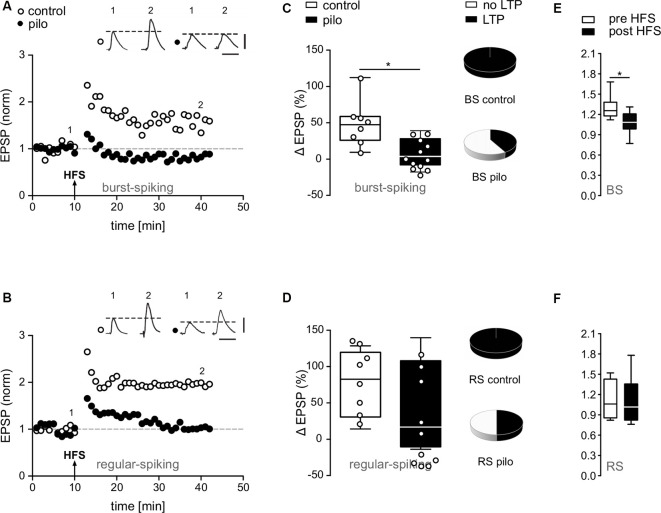
Impairment of synaptic plasticity in subicular pyramidal cells of pilocarpine-treated animals. (A,B) EPSP time courses from single cell recordings in subicular BS and RS cells before and after HFS. Note the loss of LTP in putative subicular BS and RS cells of pilocarpine-treated animals after HFS. (C,D) Summary of relative changes in synaptic strength upon HFS shown as box plots with whiskers from minimum to maximum and line at median (Control BS: 44.8 ± 1.4%, n = 8, Pilo BS: 7.6 ± 2.1%, n = 12, p = 0.004; Control RS: 75.9 ± 15.7%, n = 8, Pilo RS: 40.4 ± 19%, n = 10, p = n.s.). Pie charts depict fractions of BS and RS cells in control and pilocarpine-treated animals showing LTP. While in control animals all BS and RS cells showed a significant degree of LTP, in pilocarpine-treated animals, only five out of 10 putative RS cells and five out of 12 putative BS cells showed LTP. (E,F) The expression of LTP in control animals was accompanied by a change in PPF in BS but not in RS cells (Control BS: Pre HFS PPR = 1.3 ± 0.06, n = 8; Post HFS PPR = 1.1 ± 0.06, n = 8, p = 0.03, t-test; Control RS: Pre HFS PPR = 1.1 ± 0.1, n = 8; Post HFS PPR = 1.1 ± 0.1, n = 8, p = n.s., t-test), suggesting a presynaptic mechanism. Data is shown as box plots with whiskers from minimum to maximum and line at median. Statistical significance was set to *p < 0.05.